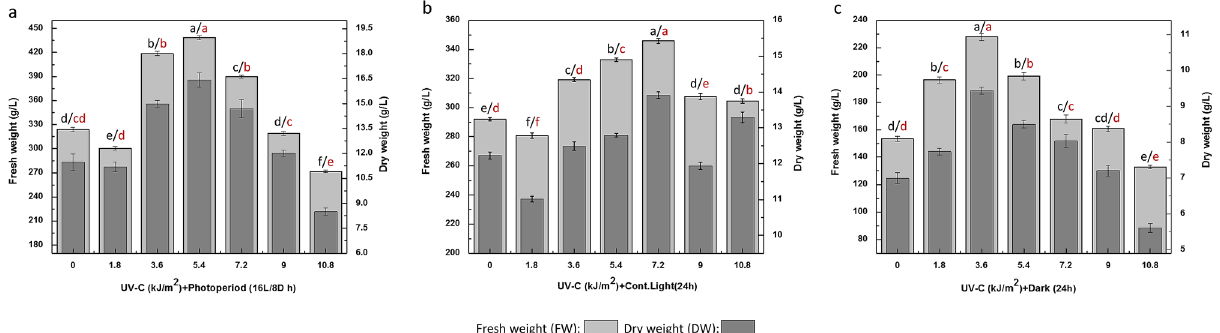
Figure 1. ( a ) Accumulation of Biomass in callus cultures of Fagonia indica under photoperiod (16L/8D h) after eliciting with various treatments (0–10.8 kJ/m 2 ) of UV-C radiations. ( b ) Accumulation of biomass in callus cultures of Fagonia indica under contineous light (24 h) after eliciting with various treatments of UV-C radiations. ( c ) Accumulation of biomass in callus cultures of Fagonia indica under complete dark (24 h) after eliciting with various treatments (0–10.8 kJ/m 2 ) of UV-C radiations. Values represented as mean ± SE of three replicates. Different (black for FW, red for DW) letters represent significant differences between the various experimental conditions ( p < 13.9 g/L) at respective dose (7.2 kJ/m 2 ) of UV-C radiation for 40 min and biomass accumulation (FW: 227.2 g/L; DW: 9.43 g/L) in dark after 20 min exposure to UV radiation (3.6 kJ/m 2 ) as compared with controls respectively [Fig. 1b, c]. The UV-C radiations with growth proliferating effects have been reported for in vitro cultures of many medicinal plants previously 35,36 . The findings of current study show highest biomass accumulation among in vitro cultures of F. indica elicited previously 1,2 . Usually, a specified span of light is absorbed by photoreceptors in plants that are entailed in certain pathways of developmental processes. For instance, light act significantly in phytochrome diversions into far-red (active prf) and sustain genes expressions, resulting in raised cell division and metabolic activities as photo-response 1 . The higher biomass accumulation could also be resulted by induction of mutations in plant cells by UV-C light 24,25 Furthermore; the photoperiod is an influencing factor responsible for growth and developmental processes in plants. Numerous studies revealed the predominant effects of light duration in regulating plant growth and levels of its significant metabolites in many plant species 37–39 . Carvalho et al. 40 ; showed a dramatic increase growth and contents in I. batatas leaves by light irradiation for 16 h as com- pared to light exposure for short time. Overall, the UV-C treatments for 20–40 min (1.2–7.2 kJ m −2 ) enhanced the callus proliferation but for extended duration of UV-C doses inhibited the cells growth under different photoperiod regimes.. The reduc- tion in biomass accumulation at higher UV-C treatments could be the result of irreversible toxic effects to cells that might raise cell death in plant cultures 35,41 and inducement of oxidative stress 42,43 . In addition, high light stress for extended hours induces photo-inhibition of photosynthetic system in plants. The resulting outcomes of extreme light exposures have previously mentioned by Kok 44 and Lichtenthaler et al. 45 , those include imbal- ance in photosynthetic O 2 and CO 2 fixation, inhibition of chloroplasts and loosed fluorescence at PS II. Usually, photo inhibition occurs mostly by multifactorial light stress; distracting the QB proteins that is responsible for catalysis of QA (primary quencher) into heavy PQ assembly via electron transfer 46–48 . Furthermore, the decreased phenolics and flavonoids in cultures in continuous dark could also be due to degradation of chlorophyll contents resulting in reduced photosynthesis 49 . Likewise, decreased cell growth and biomass proliferation in Lepedium satvium cultures under UV-C exposure for extended periods has been reported by Ullah et al. 33 . Our findings can be further elaborated and verified by several tissue cultures studies of pharmaceutical plants under UV-C exposure 36,50 .